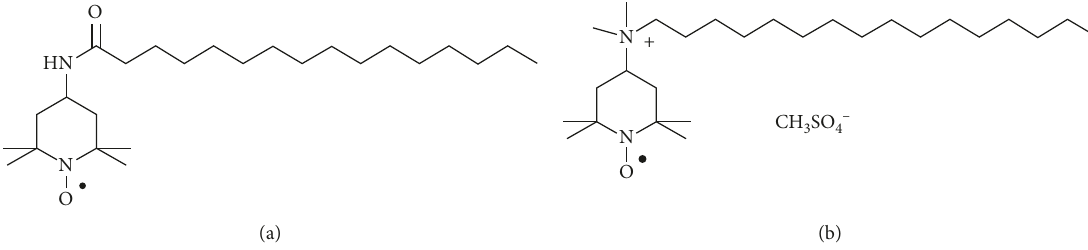
Figure 1: Structure of spin probes used in the